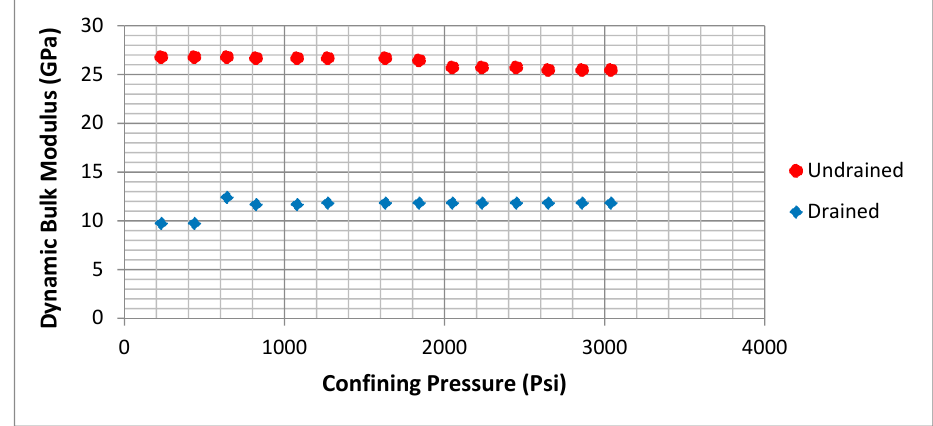
Figure 8. Undrained and drained dynamic bulk moduli vs. confining pressure for C4.